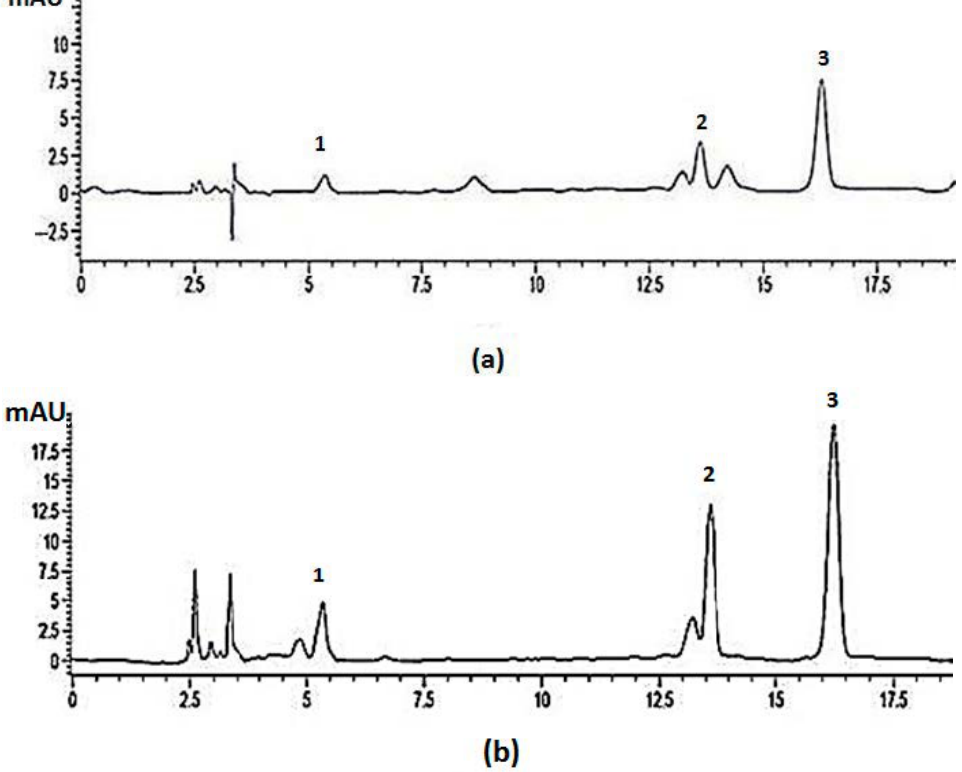
Figure 2. HPLC analysis of phenolics compounds extracted ( a ); maceration technique in 70% ( v / v ) ethanol–water from leaves of Labisia pumila , ( b ) SC–CO 2 with 70% ( v / v ) ethanol–water as a co-solvent, at 60 °C and 20 MPa from leaves of Labisia pumila , (1) Gallic acid, (2) Methyl gallate, (3) Caffeic acid.